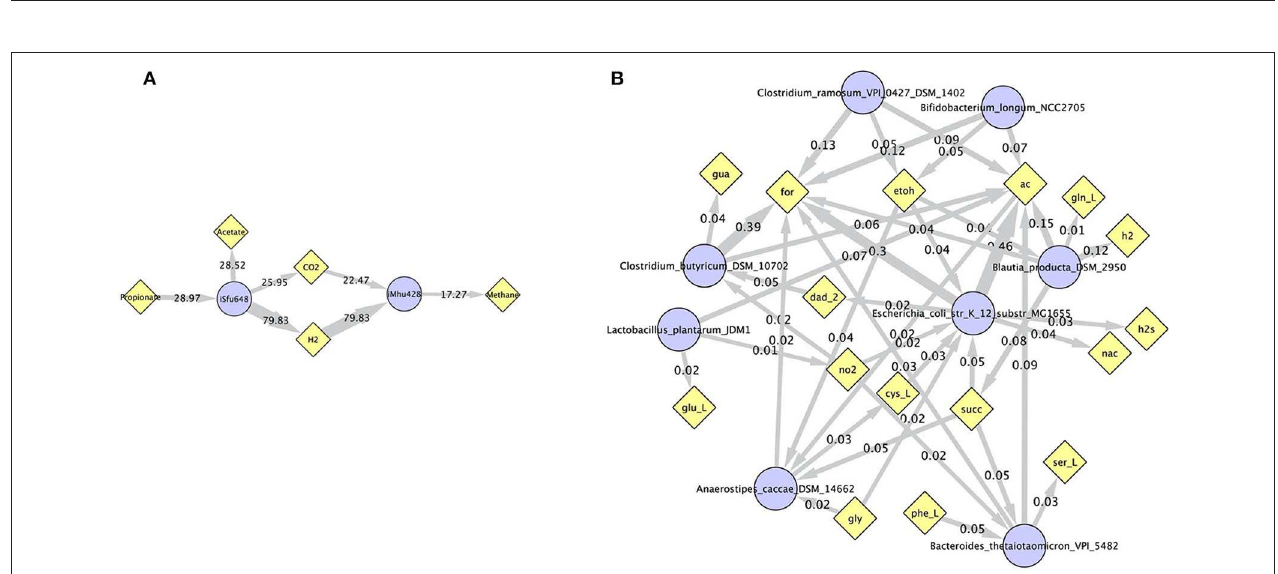
FIGURE 6 | Compound exchange at t = 0.1h for the syntrophic co-culture (A) and the simplified human gut microbiome (B) . Microbial species (blue circles) produce and consume compounds (yellow diamonds) as indicated by arrows. Numbers indicate production and consumption rates (in mM/h). In (B) , only those compounds are shown, which are both produced and consumed by at least one microbial species, and fluxes below 0.01 mM/h as well as compounds H 2 O and proton were omitted for clarity. Abbreviated compound names refer to: ac: acetate, CO2: carbon dioxide, cys_L: L-cysteine, dad_2: 2-deoxyadenosine, etoh: ethanol, for: formate, gln_L: L-glutamine, glu_L: L-glutamate(1-), gly: glycine, gua: guanine, h2/H2: hydrogen, h2s: hydrogen sulfide, nac: nicotinate, no2: nitrite, phe_L: L-phenylalanine, ser_L: L-serine, succ: succinate.